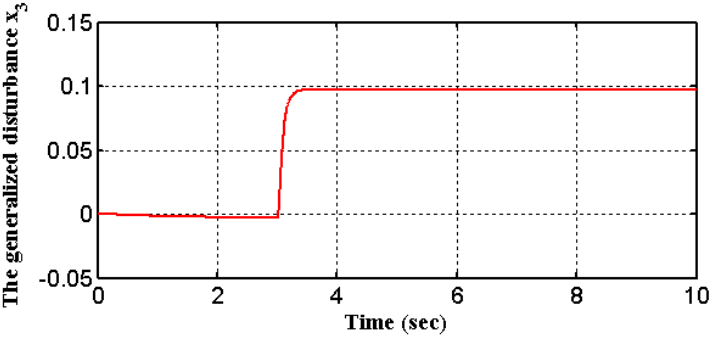
Figure 14. The results for the mass spring dumper model using C-ADRC, ( a ) output ( y ), ( b ) control signal ( u ), ( c ) the generalized disturbance.